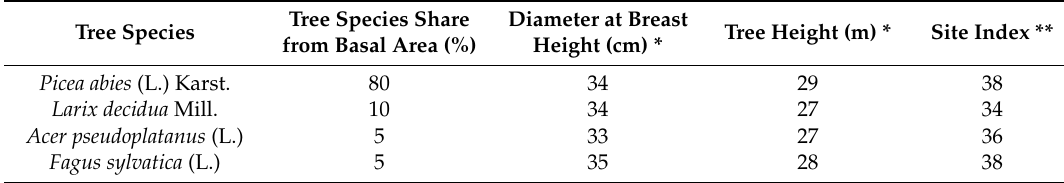
Figure 1. Location of the case study area. Table 1. Mean values of basic stand characteristics.